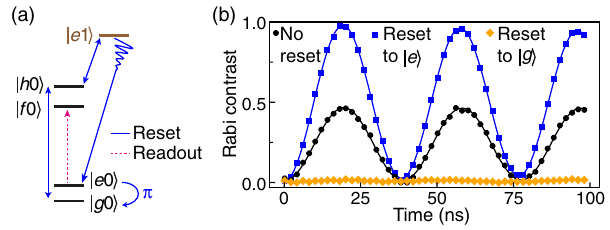
FIG. 2. Reset and readout schemes and measurements. (a) Level diagram for the reset and readout protocols, where the letters g , e , f , and h denote qubit energy levels and the numbers 0 and 1 denote resonator levels. Reset is performed by simultaneously driving both j g 0 i → j h 0 i and j h 0 i → j e 1 i transitions (blue double-headed arrows). The spontaneous photon decay j e 1 i → j e 0 i provides a directional transition (blue single-headed arrow), removing the entropy and completing the reset. An j e 0 i → j f 0 i π pulse is applied before the readout to boost the output signal. (b) Rabi oscillations between j e i and j f i for different initial state preparations. Black circles: The initial state is the thermal equilibrium state. Blue squares: The initial state is prepared in j e i before the j e i ↔ j f i Rabi. Orange diamonds: The initial state is prepared in j g i